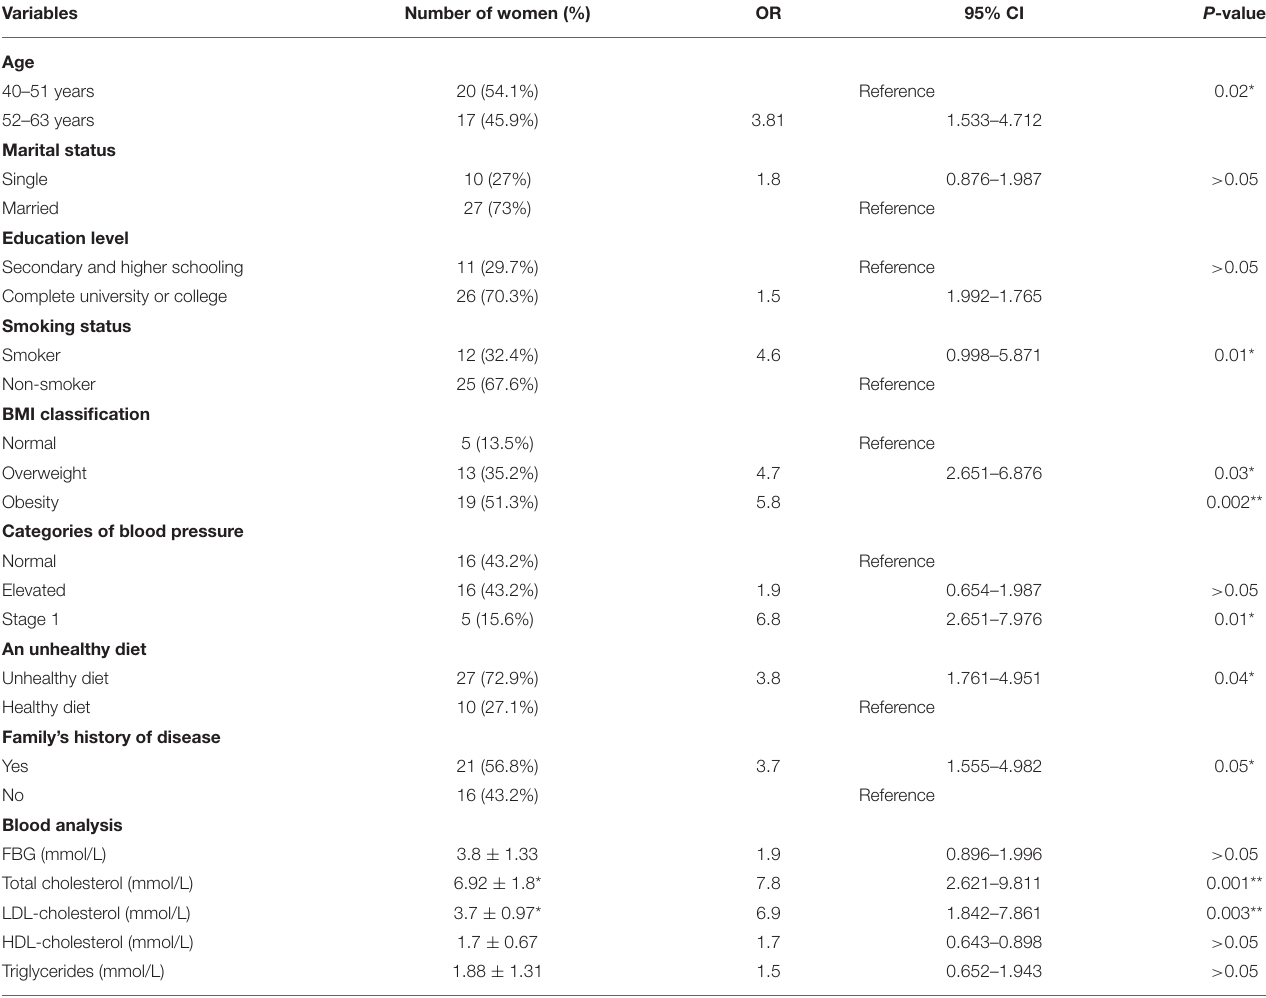
TABLE 4 | Factors associated with 10-year CVD risk estimate among women with intermediate and high risk ( n =